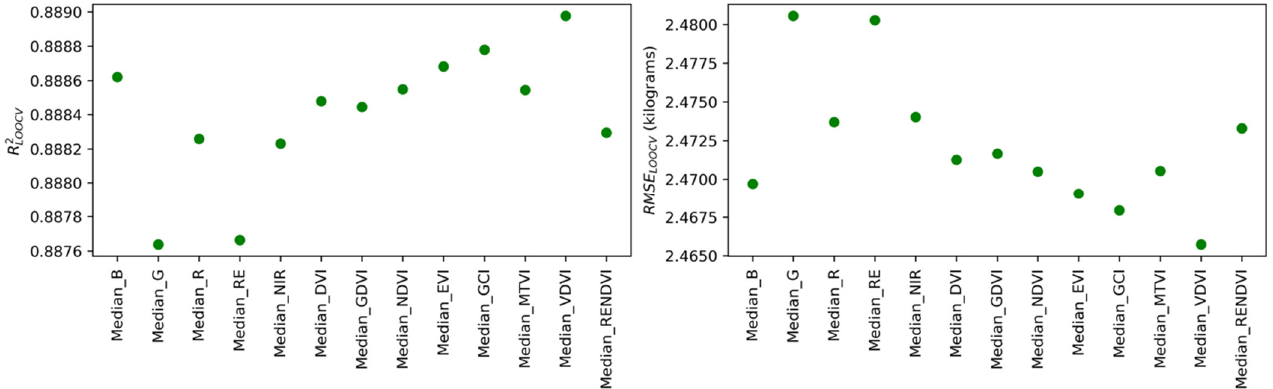
Figure 8. The area-augmented table beet root mass R 2 ( left ) and RMSE ( right ) leave-one-out cross-validation performance (y-axis) for individual multiple linear regression models. Each model consists of one reflectance band or vegetation index shown on the x-axis combined with canopy area. The VDVI paired with canopy area was the best-performing model with R 2 = 0.89 and RMSE = 2.5 kg. However, the vertical axis scaling shown for both plots indicates that the radiometric data provide no significant improvement to the table beet root mass model derived from the area-augmented imagery.